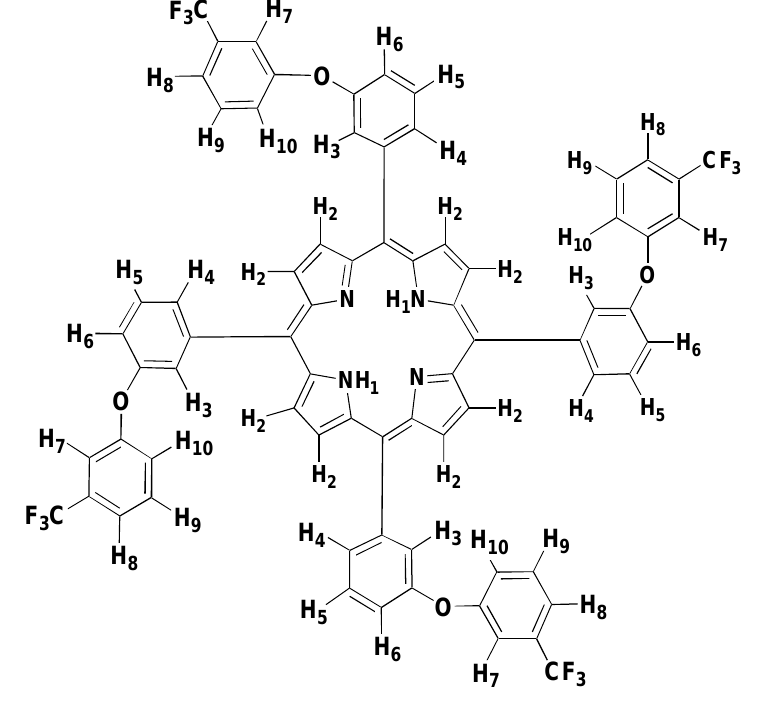
Figure 1 . Structure of TTFMPP with protons numbered for NMR